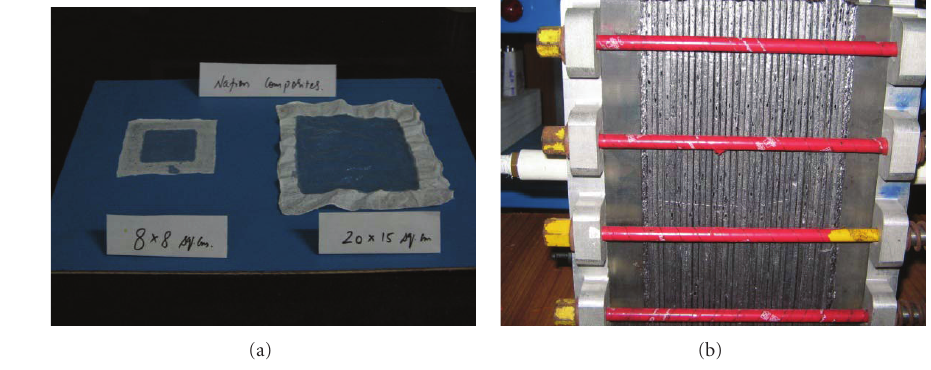
Figure 8: Composite membranes fabricated and the 20 cell PEMFC stack.